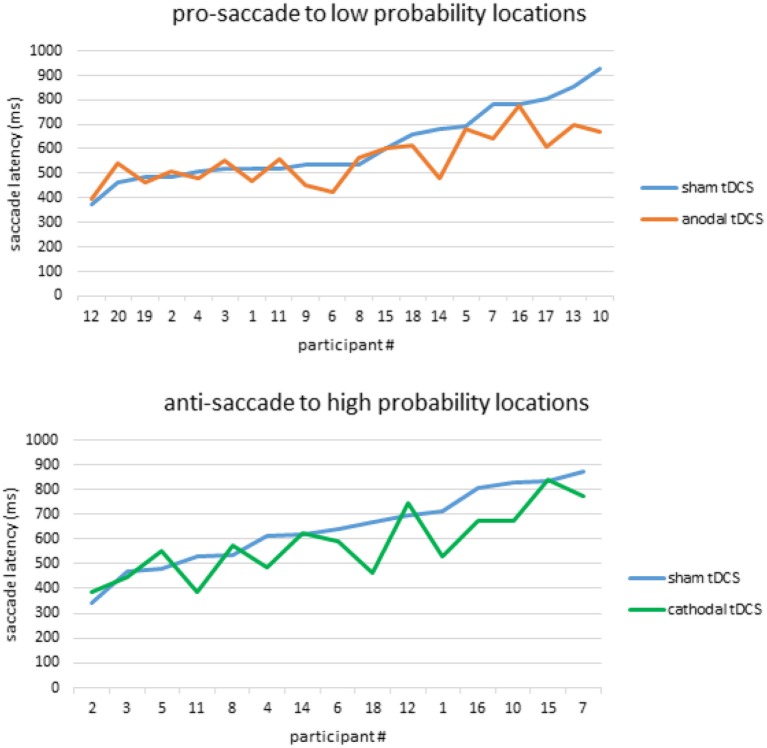
Individual differences in responsiveness to tDCS. Anodal tDCS facilitated prosaccades toward high-probability locations (Top) while cathodal tDCS facilitated antisaccades toward high-probability locations (Bottom). These effects were mainly driven by low-performers who showed slower saccade latencies in the sham condition, as evidenced by the enlarged gap between the blue and orange lines in panel 1, and blue and green lines in panel 3.